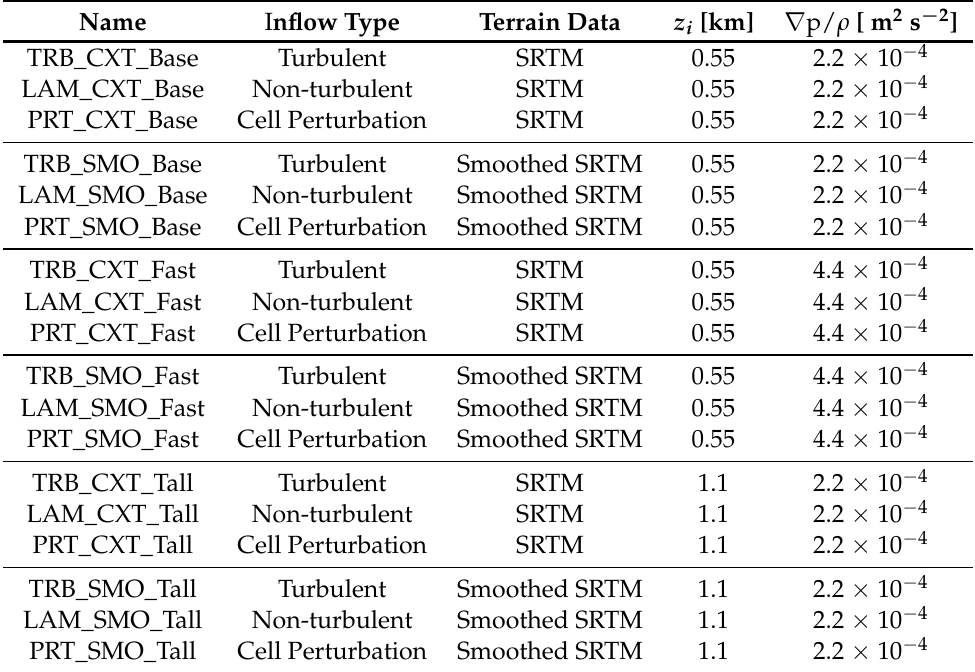
Table 1. Simulation suite of perturbation methods and terrain complexity carried out in the cur- rent